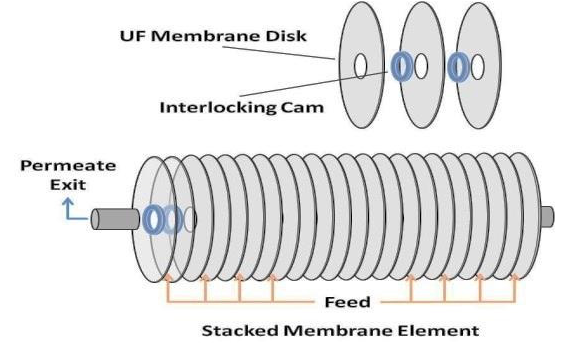
Figure 2. Rotating membrane module FUV-185-A15R manufactured by Avanti Membrane Technology, Walnut, CA,